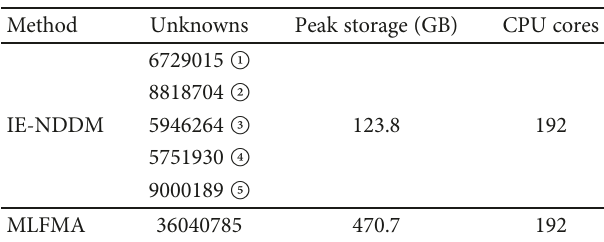
Figure 12: Model of the aircraft divided into fi ve parts. Table 1: Computational statistics of